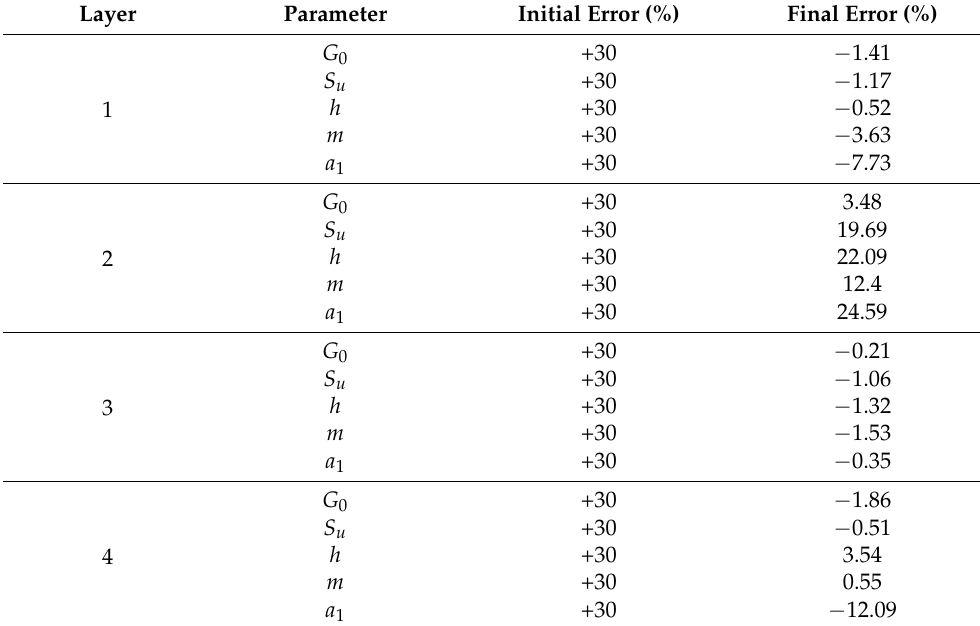
Table 3. The initial error and final error of estimation parameters for Case Study 4.